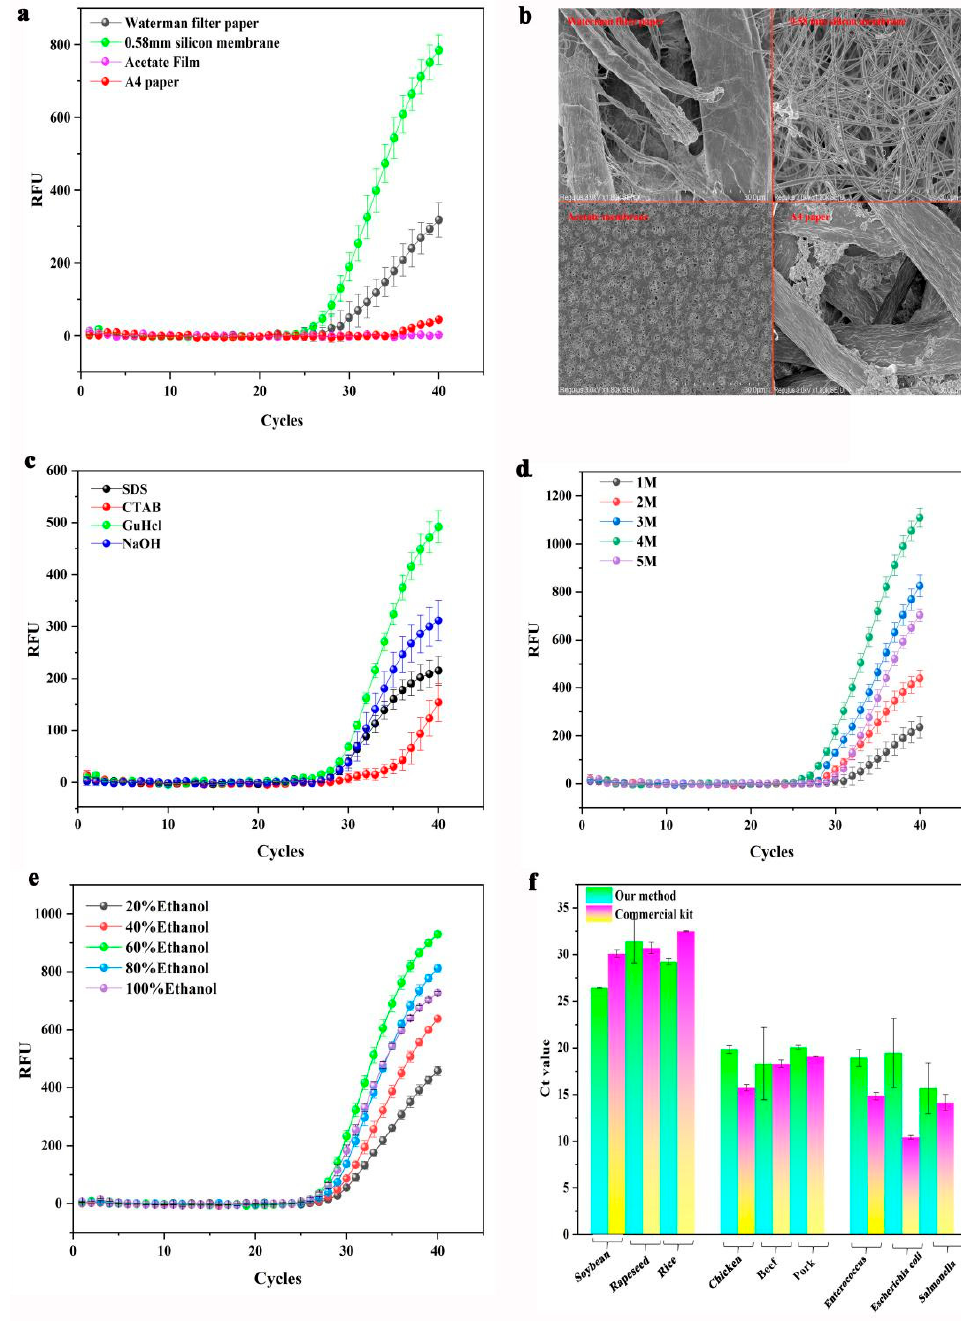
Figure 3. Establishment of ultrafast DNA adsorption system. Each experiment in this work was repeated three times independently: ( a ) selection of adsorption materials; ( b ) microscopic images of adsorption materials; ( c ) screening of lysis buffer; ( d ) the PCR amplification curves of amplicons from five concentrations of guanidine hydrochloride lysate adsorbed DNA as targets; ( e ) screening results of washing solution; ( f ) the PCR amplification results in different samples of nucleic acids adsorbed by SMART.